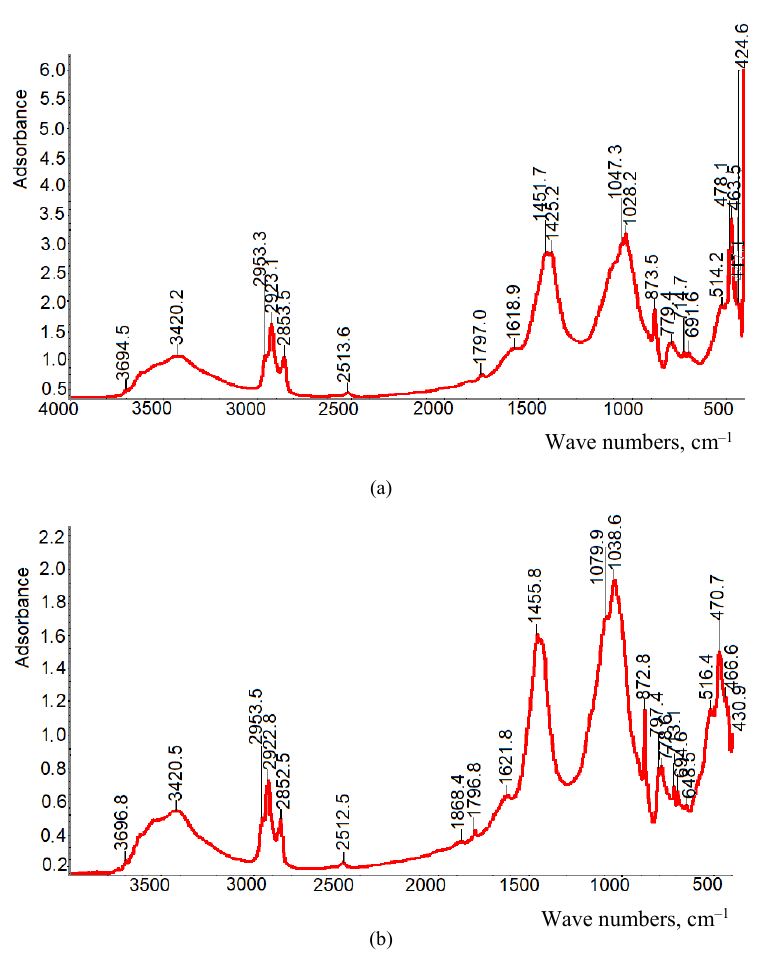
Fig. 4. The IR spectra of soil - concrete produced on the basis of sludge : a) experimental, b) control